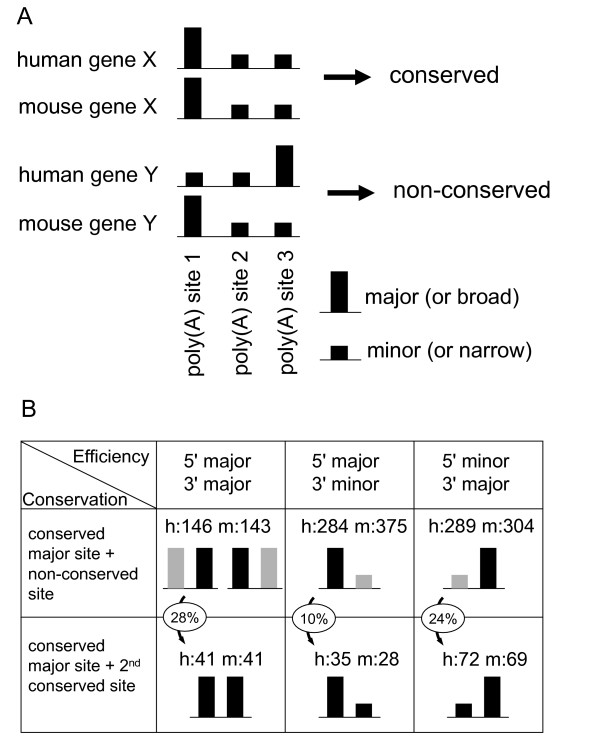
Spatial efficiency/specificity patterns and conservation. (A) Definition of spatial efficiency/specificity patterns. Ortholog gene pairs with identical numbers of conserved polyadenylation sites are considered. A conserved pattern is defined as a series of sites between two orthologous genes, where each site bares the same properties (major/minor or broad/narrow) as its orthologous counterpart (e.g. gene X). All other patterns are defined as non-conserved (e.g. gene Y). (B) Relationship between tandem poly(A) site spatial patterns and conservation. The first row shows different patterns in which one major site is conserved. The second row shows different patterns in which two sites are conserved. Numbers of human genes ("h") and mouse genes ("m") displaying each pattern are shown. Circled numbers indicate ratio of patterns in second row over patterns in first row.